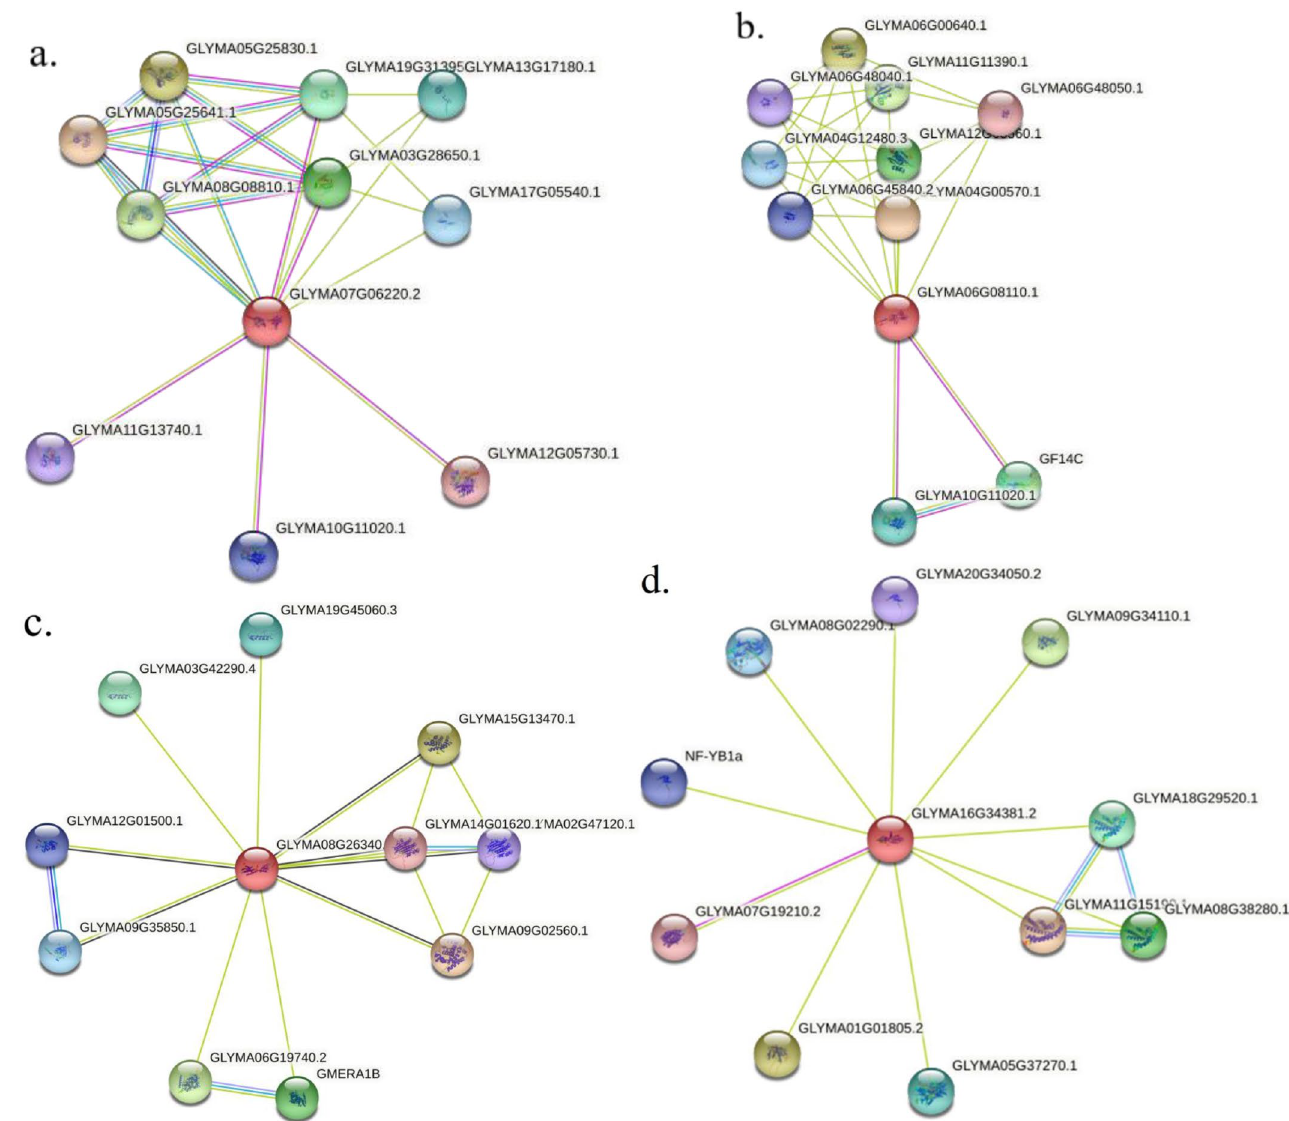
F igure 12. Protein inte raction network diagram (( a – d ) represent GmCNGC5 , GmCNGC22 Figure 12. Protein interaction network diagram (( a – d ) represent GmCNGC5 , GmCNGC22 GmCNGC27 GmCNGC27 and GmCNGC31 , respectively). and GmCNGC31 ,